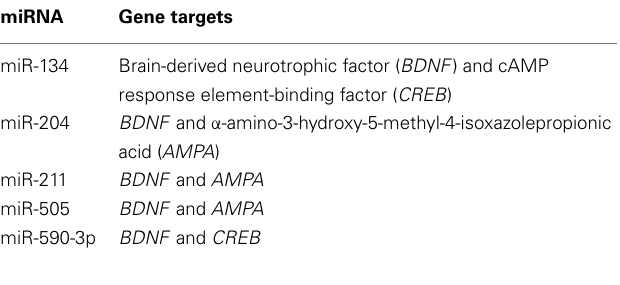
Table 1 | miRNAs predicted to regulate genes linked to MAM-induced DNA damage ( O 6 -methylguanosine) in the brains of MAM-treated mice lacking the DNA-repair enzyme O 6 -methylguanine methyltransferase (based on data in Figure 3 of Kisby et al.,